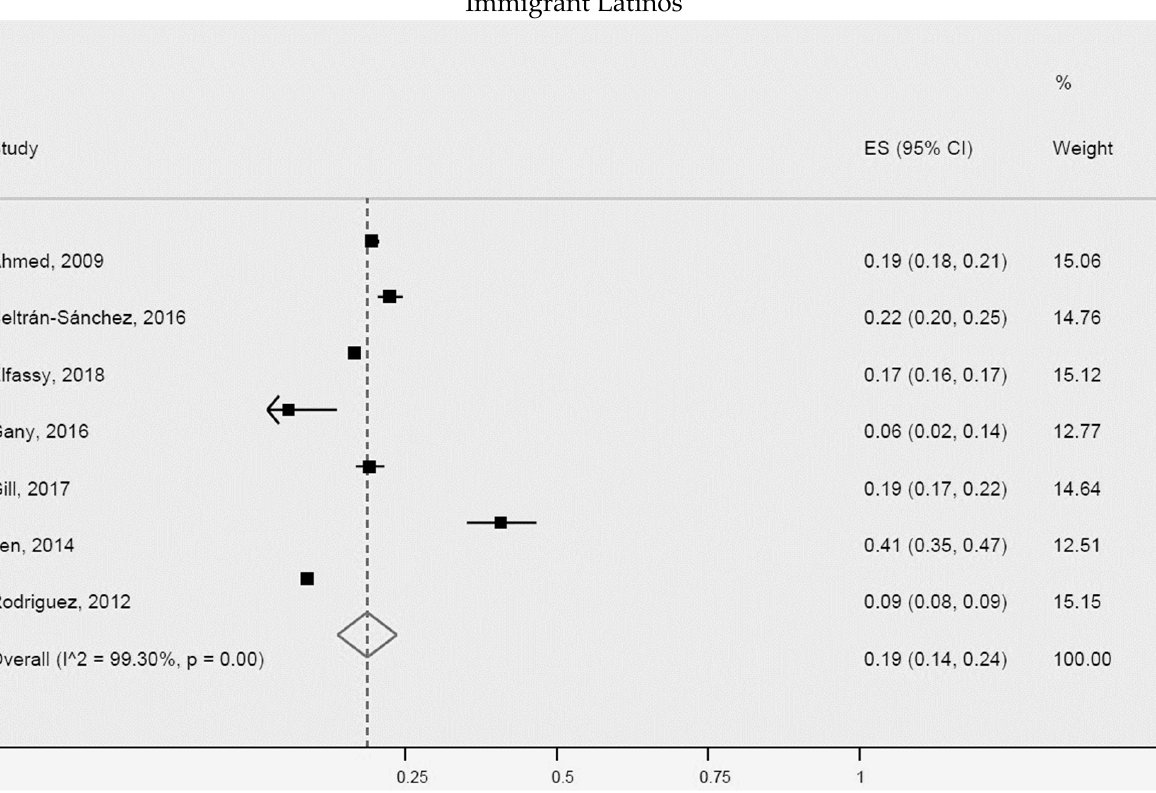
Figure 5. Type 2 diabetes mellitus or high blood glucose for immigrant Latinos and US ‐ born Lati ‐ nos. ES = Estimated proportion/prevalence; CI = Confidence interval; I^2 = I 2 index. General Obesity and Abdominal Obesity for Latinos in the US Of the 41 studies assessing general obesity (BMI ≥ 30 kg/m 2 ), 26 collected measure ‐ ments of weight and height of participants [14,15,26,27,30–34,37,40,43,46,50–52,60,61,63– 67,72–74] (one study classified participants as “overweight or obese” [31] on the basis of